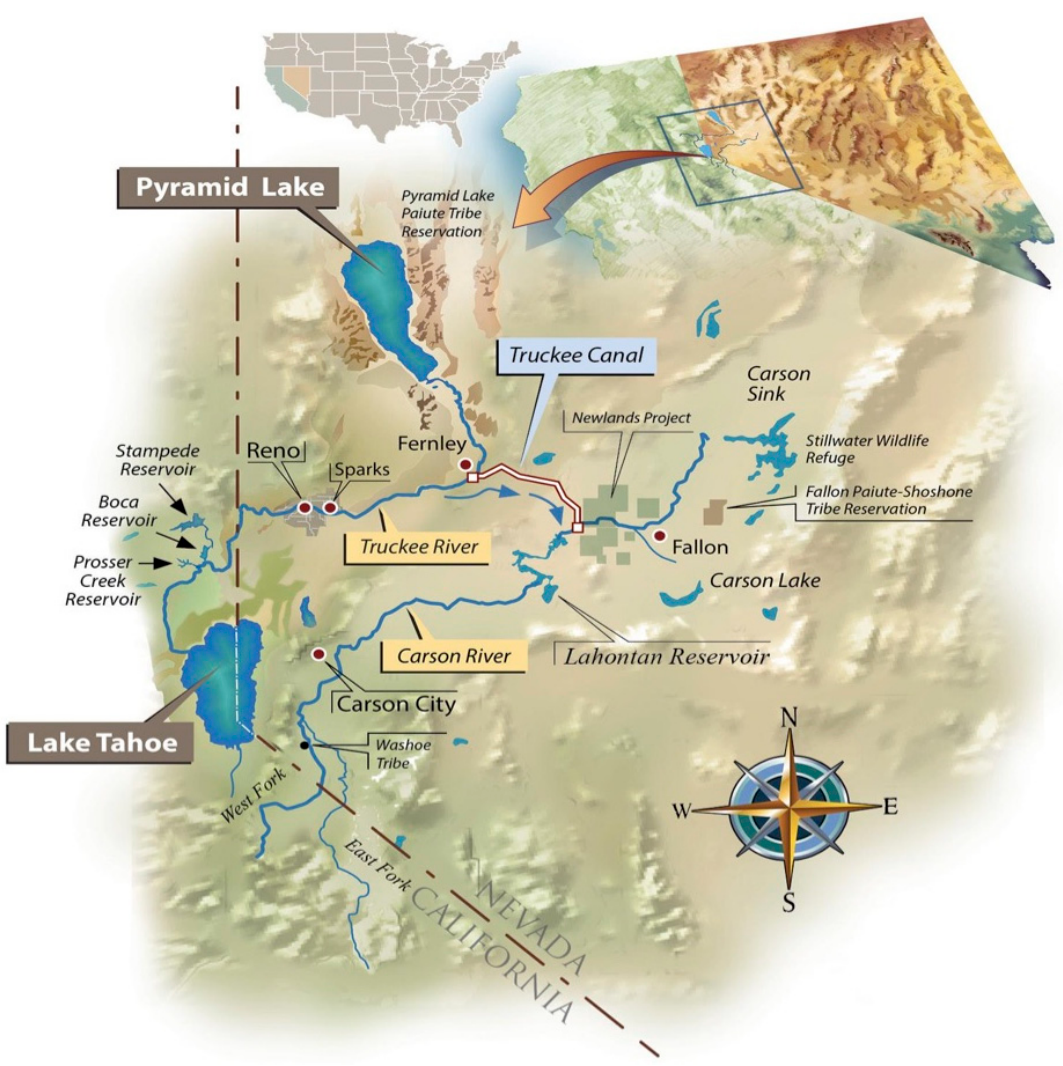
Figure 1. Truckee ‐ Carson River System. Figure 1. Truckee-Carson River